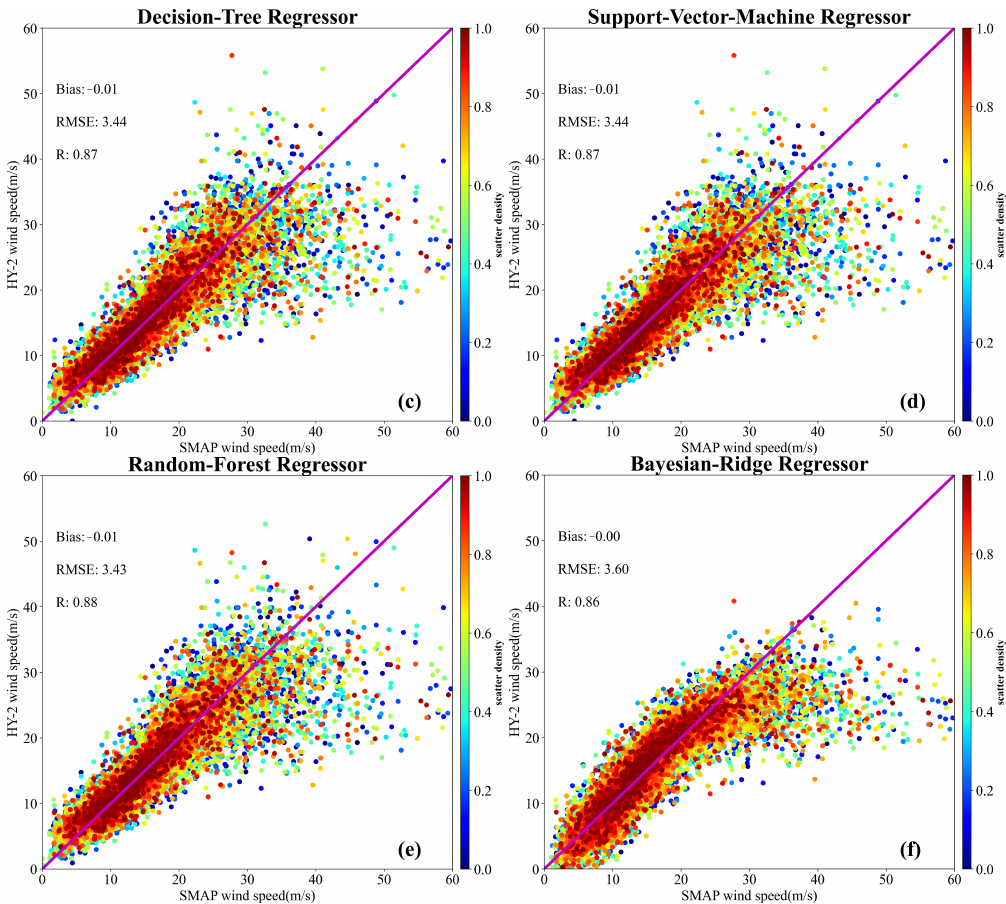
Figure 6. Scatterplots of the revised high wind speeds from HY-2B/C/D scatterometers by machine learning with respect to those from the SMAP radiometer. ( a ) BP-NN algorithm; ( b ) KNN algorithm;